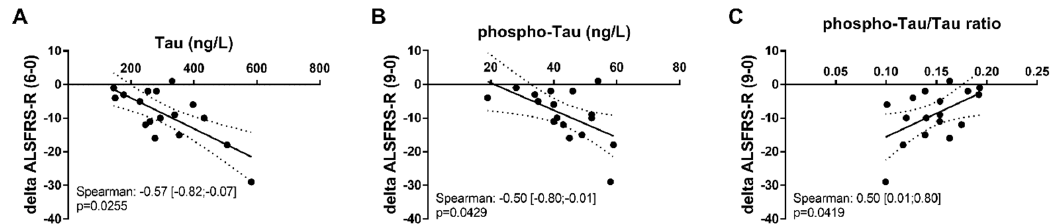
Figure 2. Correlation of ALSFRS-R variation with CSF biomarkers. ( A ) Correlation of total Tau with ALSFRS-R variation at month 6, ( B ) correlation of phospho-Tau with ALSFRS-R at month 9, and ( C )